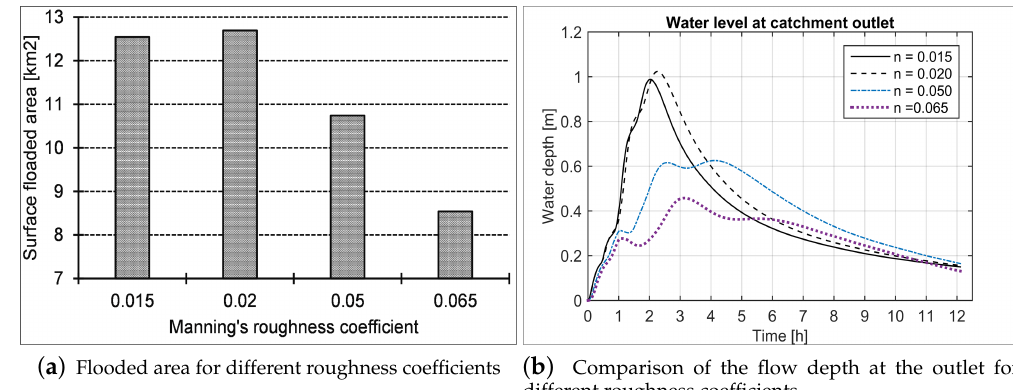
Figure 7. Cumulative flooding of the water level at the outlet for different Manning